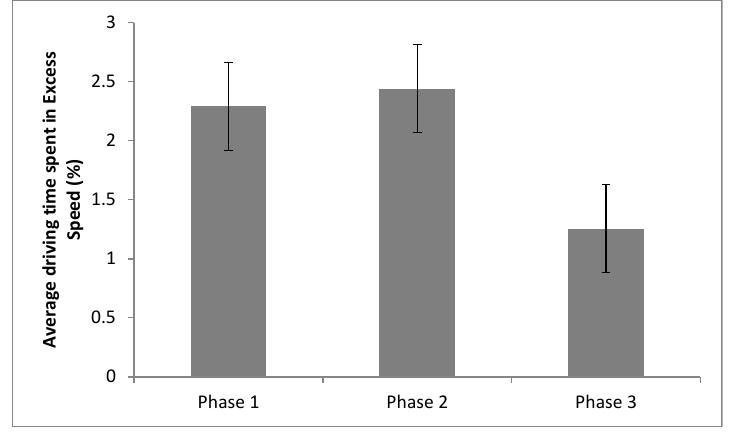
Figure 7. Average percentage of driving time in Excess